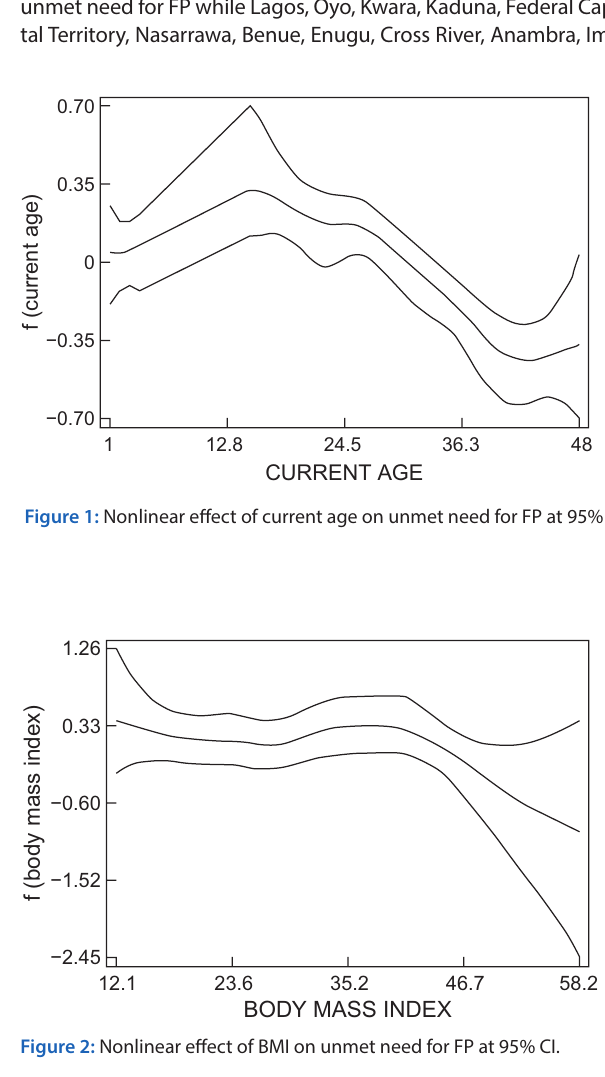
Note: White denotes states with strictly positive CI (significant high risks), black denotes states with strictly negative CI (significant low risks) and grey denotes states with insignificant risk of unmet need for FP. Figure 3: Posterior estimate of spatial pattern of unmet need for FP in Nigeria at 95% CI.